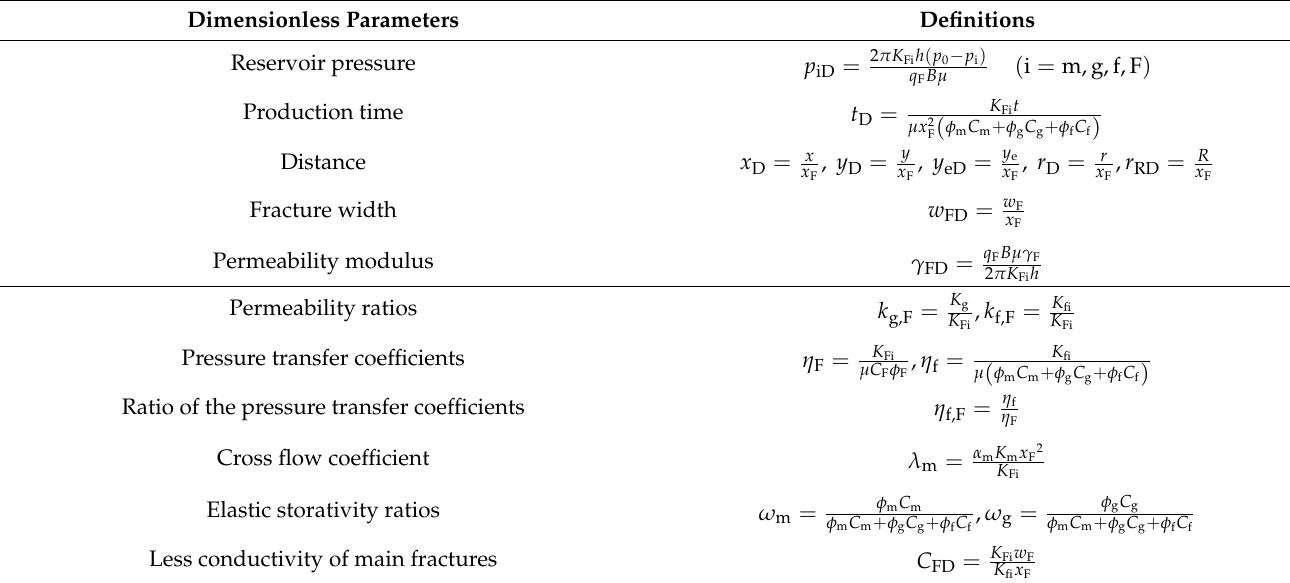
Table 1. Definitions of dimensionless variables.